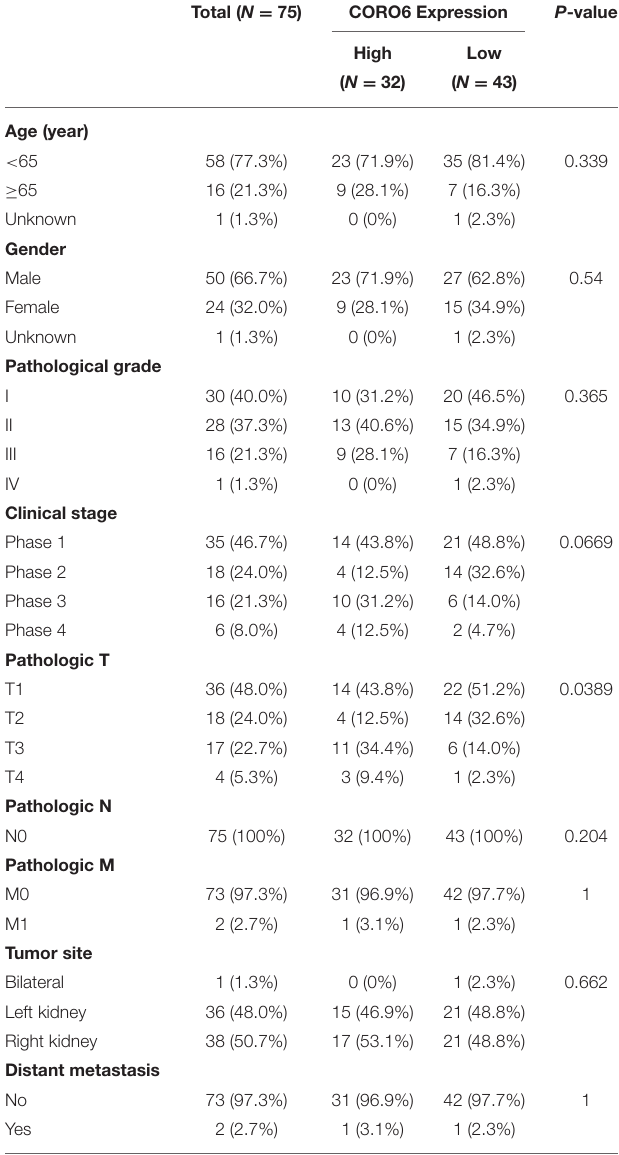
TABLE 1 | Correlation between clinicopathological variables and CORO6 expression in